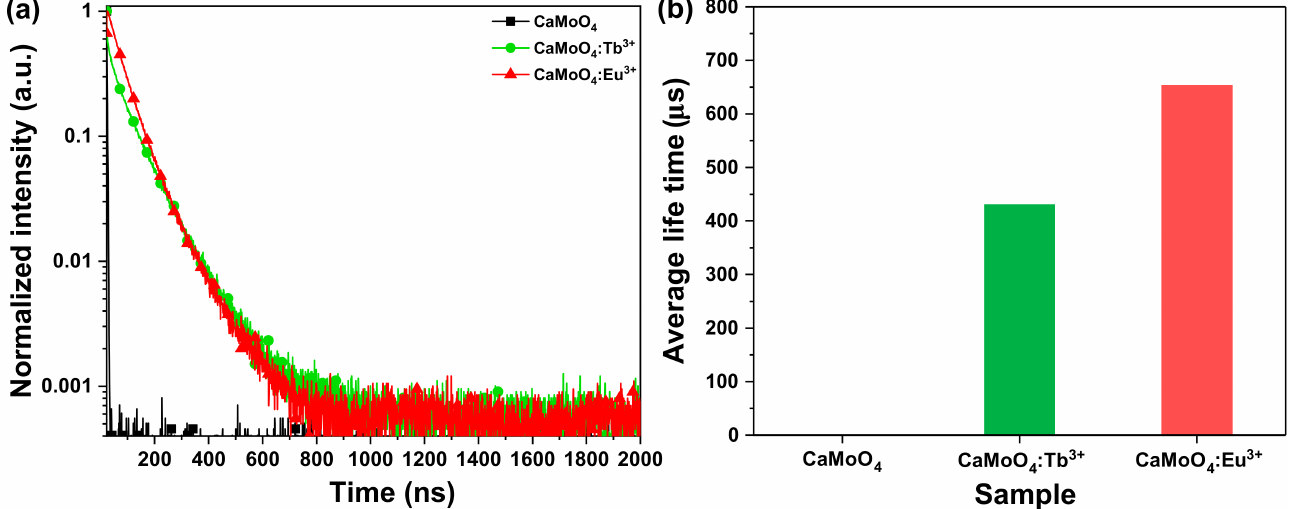
Figure 6. ( a ) Time-resolved PL and ( b ) average decay